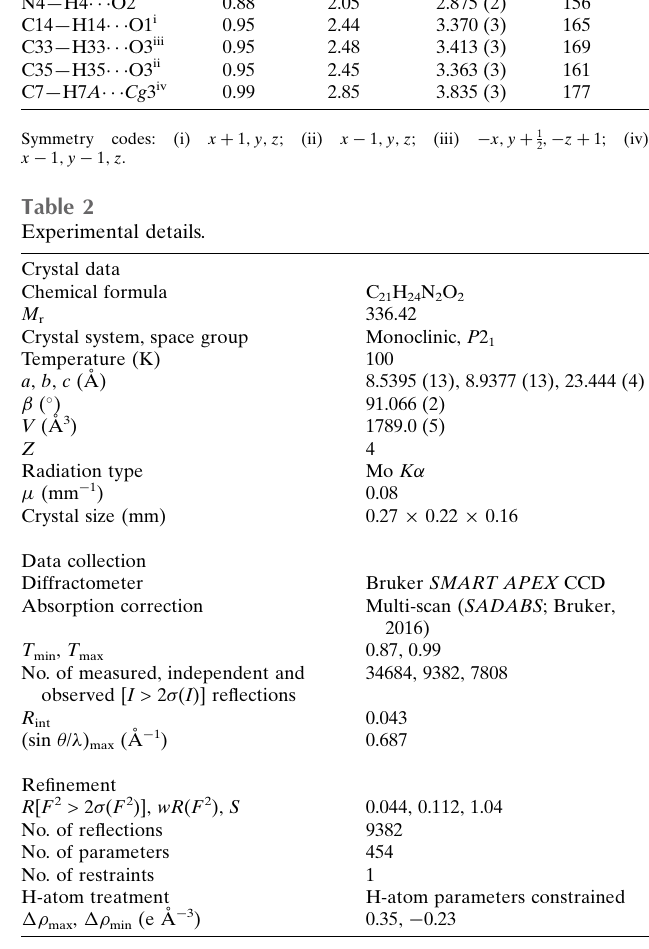
(Table 1 and Fig. 2; Cg 3 is the centroid of phenyl ring C16–